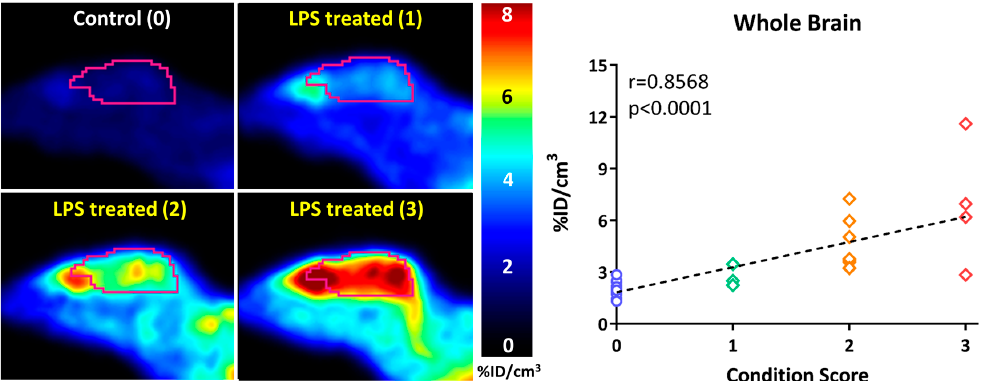
Figure 6. The uptake of [ 18 F]ROStrace correlates with the condition score (degree of “sickness”) following treatment with lipopolysaccharide (LPS).